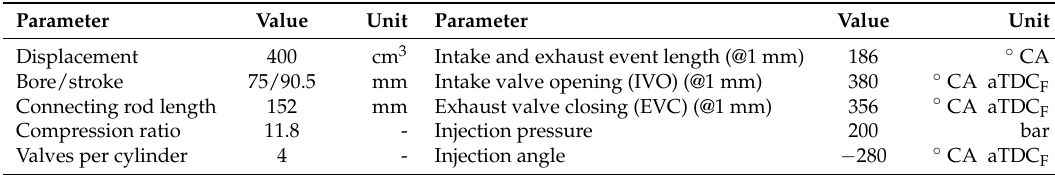
Table 1. Single-cylinder engine technical data and operating